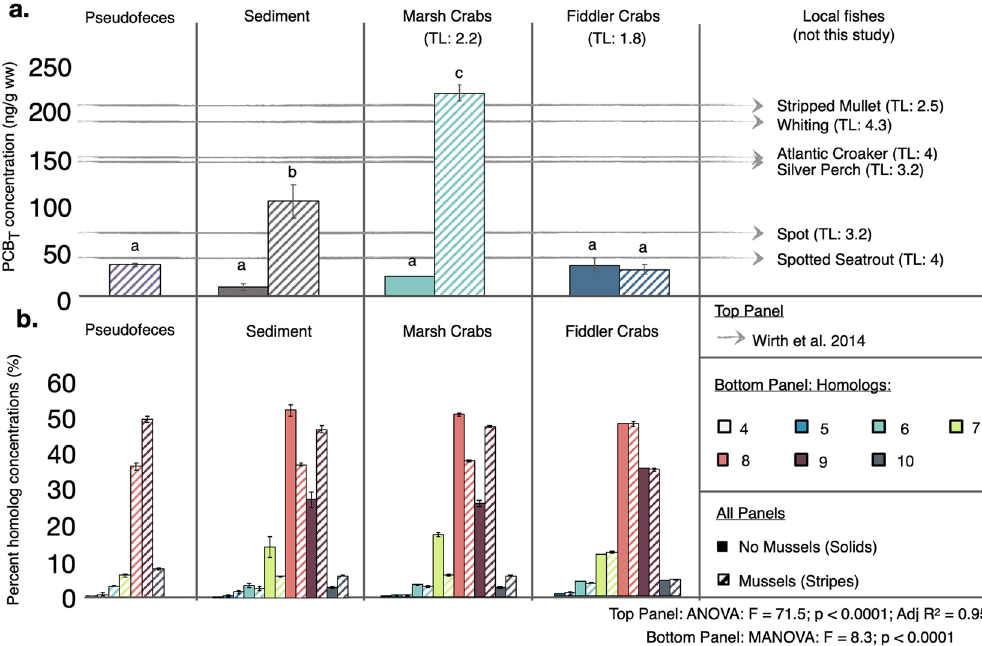
Figure 3. Mussel effects on PCB T and PCB homolog distribution. PCB T , reported as the sum of 100PCB congeners in ng/g wet weight ( a ), and the percent concentration of PCB homologs Cl 4 –Cl 10 ( b ) in pseudofece, sediment, fiddler crabs, and marsh crabs (left to right), collected from enclosures without mussels (solid bars) and with mussels striped bars. Data are shown as the mean ± standard error of 3 replicate enclosures per treatment. In ( a ), the total concentration of the same 100 PCBs measured in our study were previously recorded in stripped mullet, whiting, Atlantic croaker, silver perch, spot, and spotted seatrout filets (gray arrows; TL = Trophic Level 34 ), common fish collected from the TRBE 24